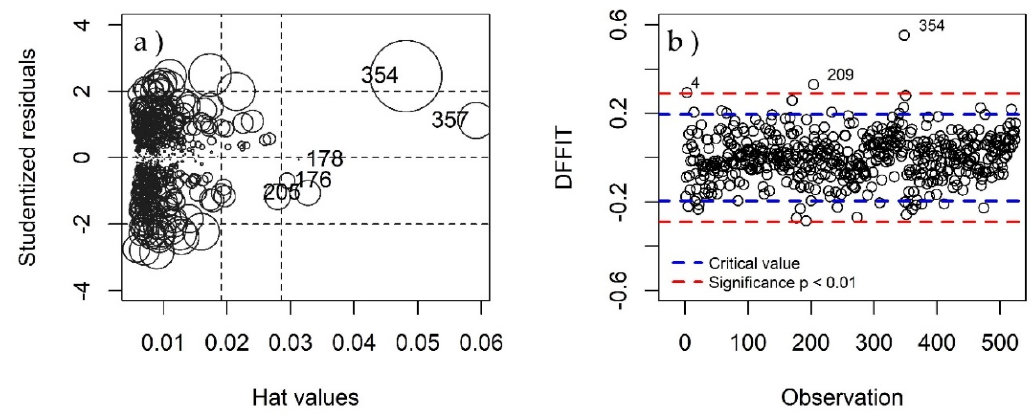
Figure 5. Detection of potentially influencing observations ( a ) and observations influential in estimation ( b ) of Equation (4) for estimation of aboveground biomass of Agave lechuguilla Torr. in México.